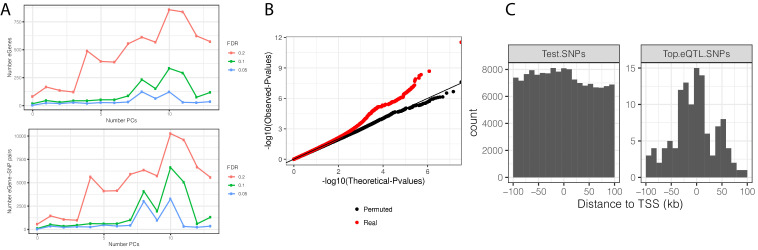
eQTL mapping in chimpanzee samples.(A) The number of significant variant:gene pairs and eGenes is plotted when varying numbers of principle components included as covariates. (B) QQ-plot of p-values for all variant:gene pairs tested shows inflation compared to sample permutation control. (C) For eGenes (FDR < 0.1), the distribution of distances of the top eQTL variant to the transcription start site, compared to the distribution of all test variants in eGenes.